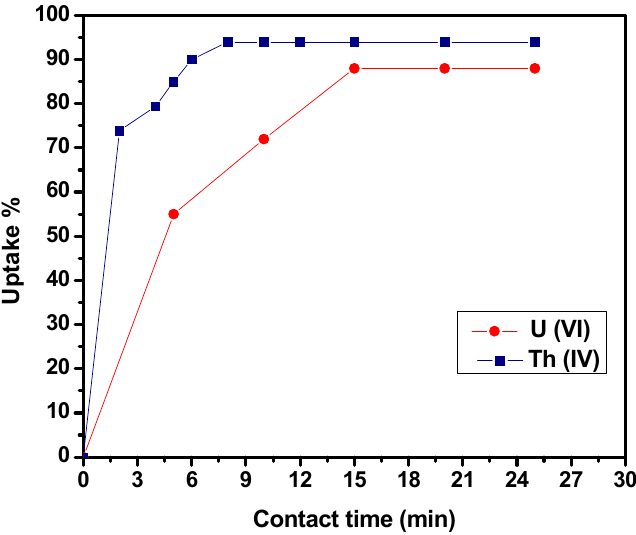
Figure 6. Effect of contact time on U(VI) and Th(IV) ions sorption onto HQ-bentonite. Conditions: 0.1 g HQ-bentonite; 50 mL solution; 100 mg/L metal ion; U(VI) (pH, 4), Th(IV) (pH, 3); temperature 303 K.